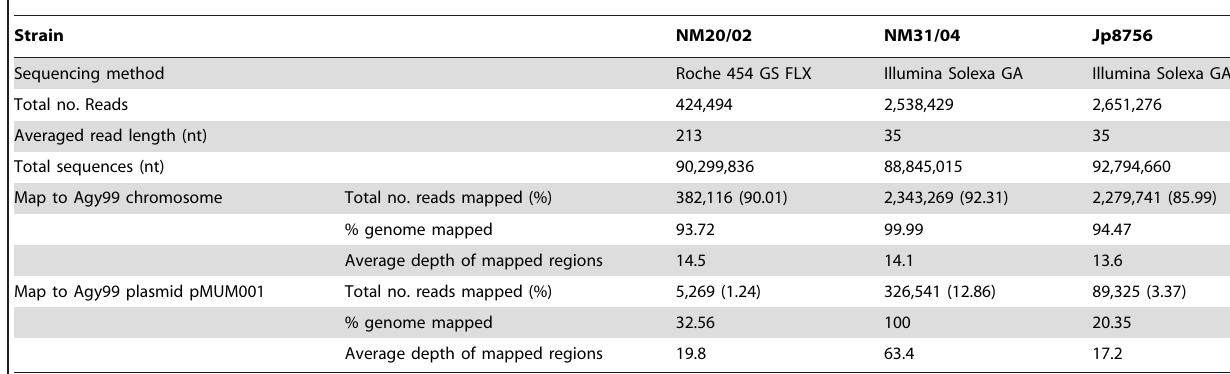
Table 2. Summary of next generation sequencing